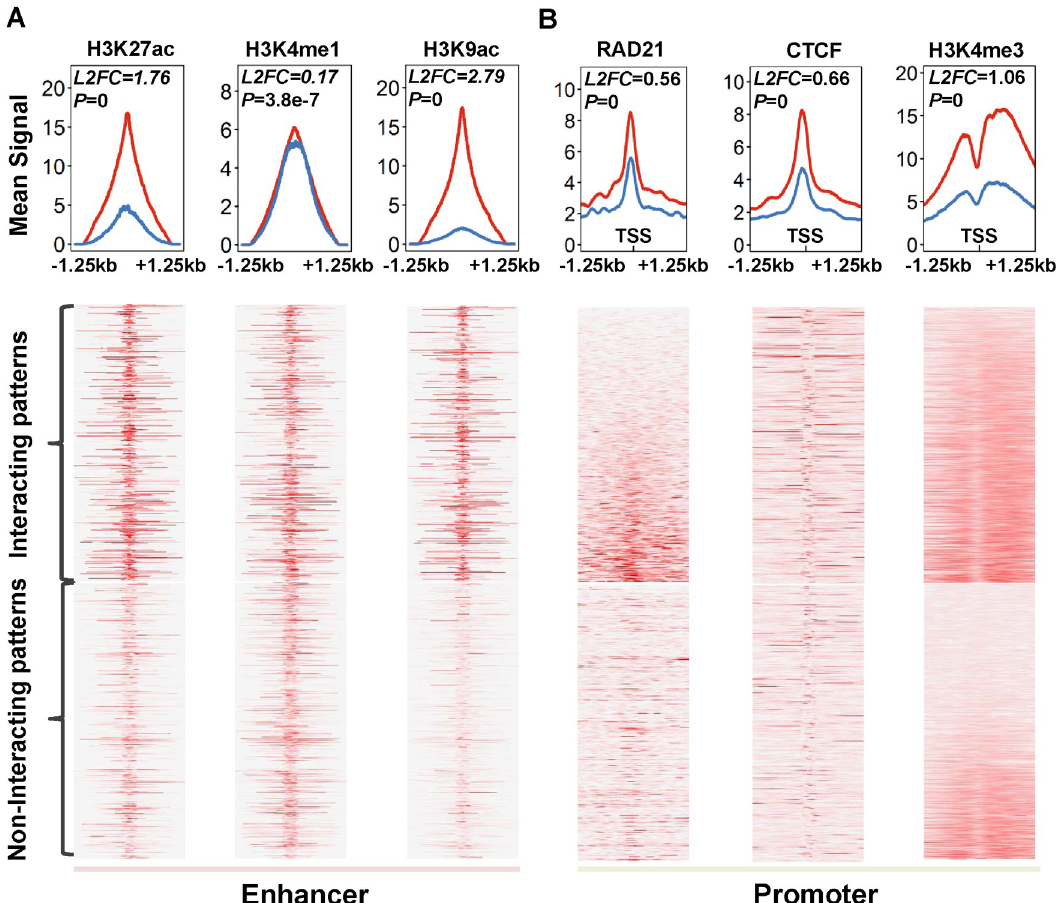
Fig 7. Chromatin states of interacting or non-interacting enhancers/promoters marked by related TFs or epigenetic modifications. (A) Density analysis and heatmaps for enhancers using enhancer marks (H3K4me1, H3K27ac, and H3K9ac). (B) Density analysis and heatmap for promoters using promoter marks (RAD21, CTCF, and H3K4me3). Total 7531 interacting and 1491 non-interacting enhancers in GM12878 were used for this analysis. Red lines marked the mean signal of the interacting enhancers (A) or promoters (B), while blue lines labeled the non-interacting elements. The p-value and log base 2 fold change (L2FC) in each plot indicated the statistically significant difference between interacting elements and non-interacting ones.